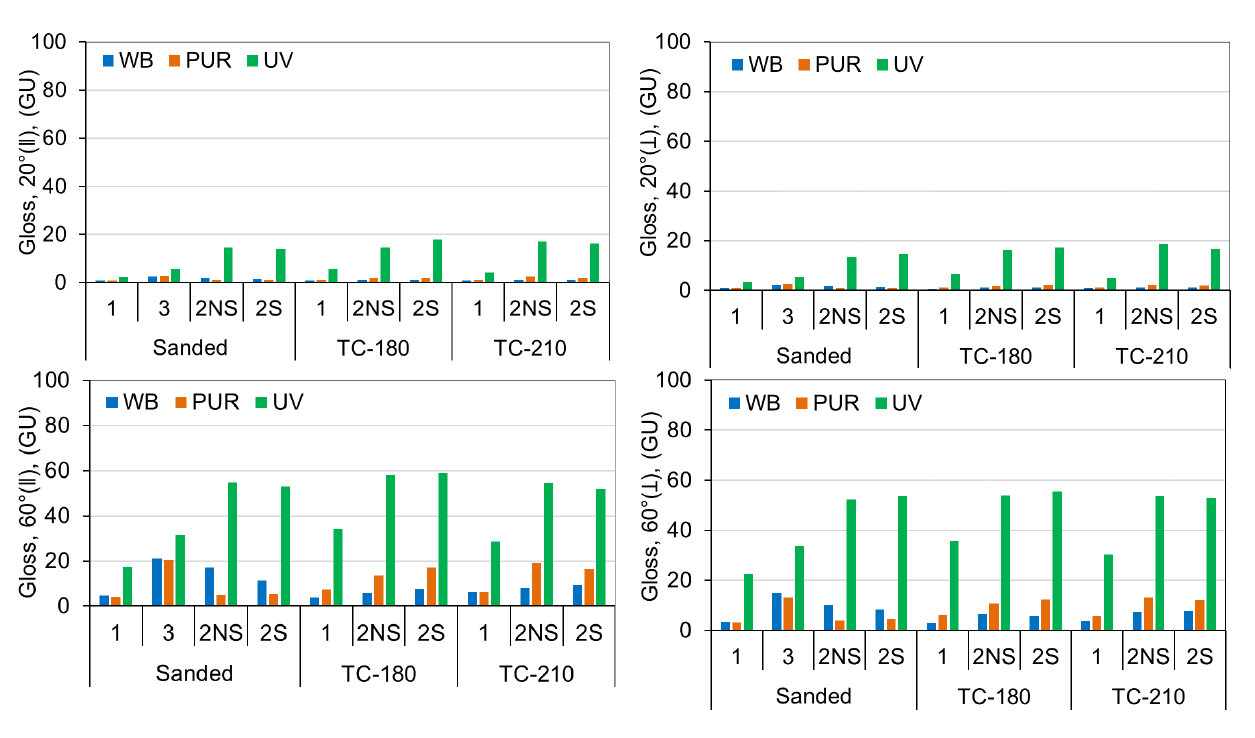
Table 1. ANOVA of surface gloss for varnished